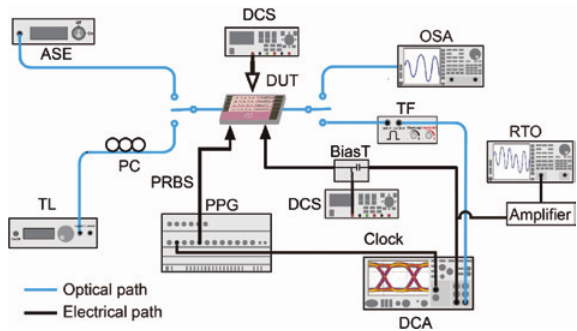
Figure 4: Experimental setup for characterizing the